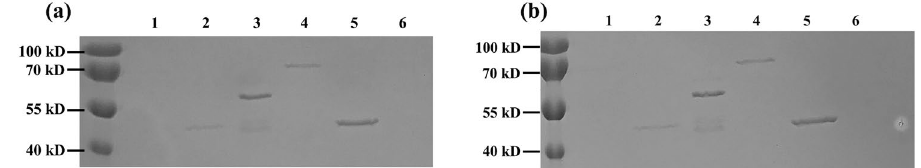
Figure 5. Binding properties of rPfY2 with main shell components. Lane 1–3, BSA, MBP, rPfY2 binding with calcite ( a ), aragonite ( b ) after flushing with water and protein elution buffer three times each, respectively. Lane 4–6, residual unbound BSA, MBP, rPfY2 in 1 st wash fraction after incubation with calcite ( a ), aragonite ( b ), respectively. Please refer to Suppl. Figs S7 and S8 to get the primary gel